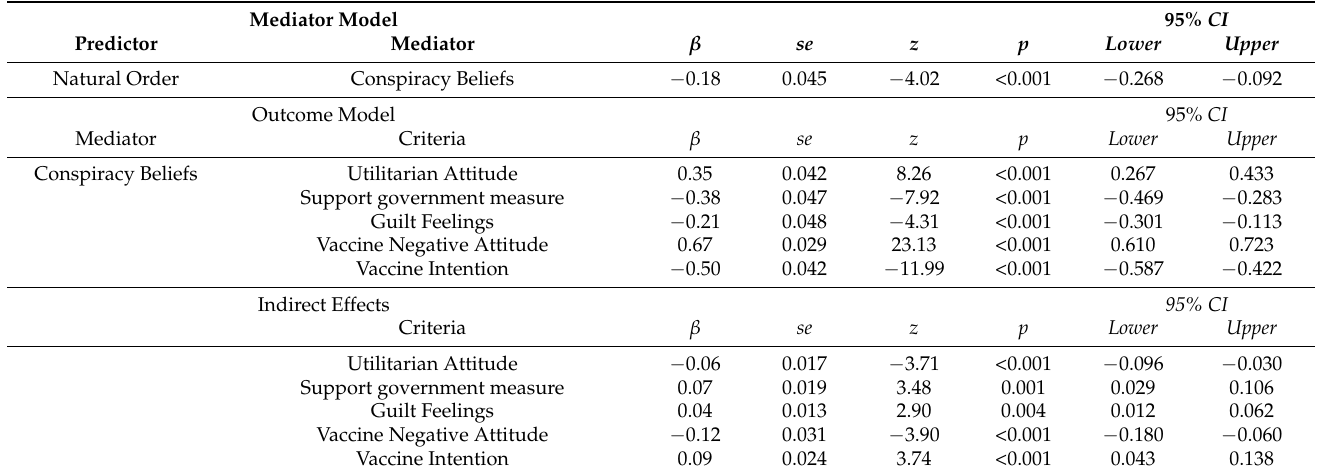
Table 3. Results of Path Analysis